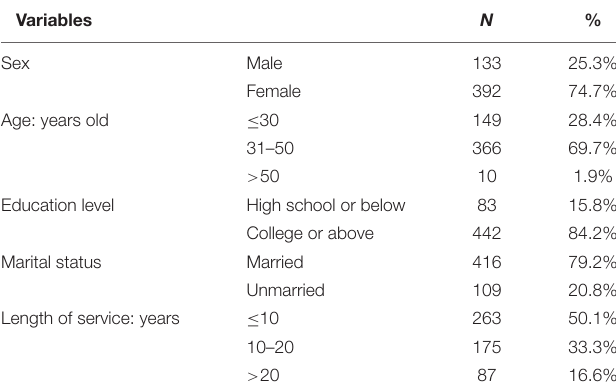
TABLE 1 | Socio-demographic of the frontline medical staff ( N =